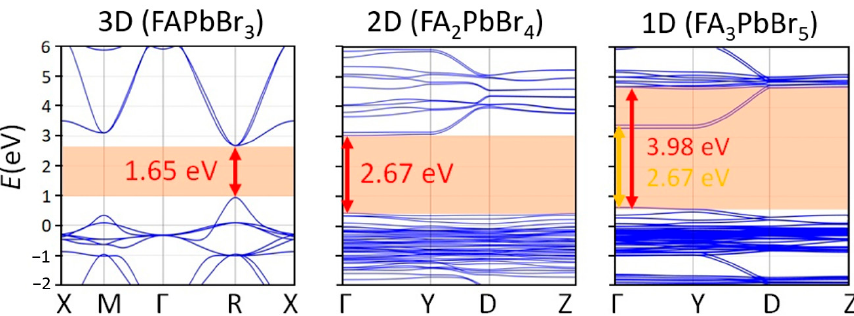
Figure 4. Calculated band structures for FAPbBr 3 (3D), FA 2 PbBr 4 (2D) and FA 3 PbBr 5 (1D) phases.